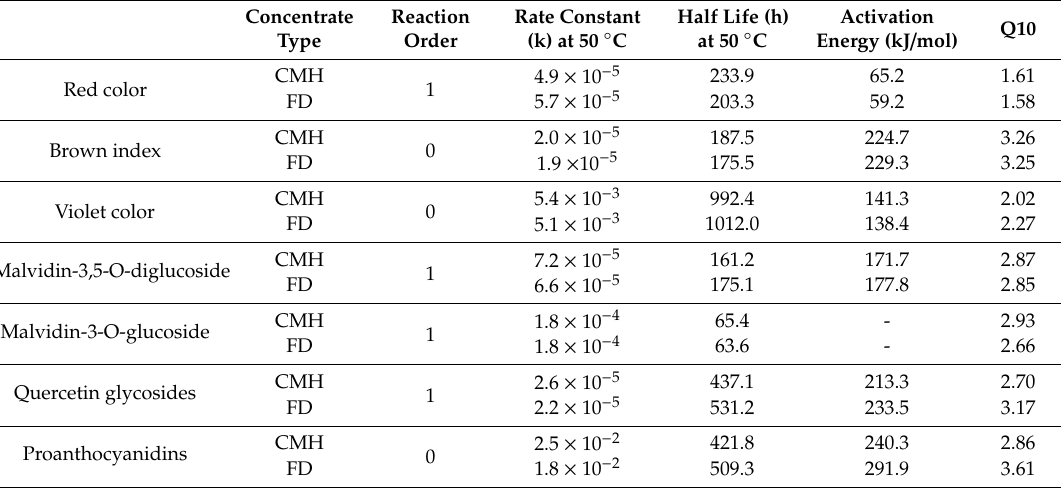
Table 5. Kinetic parameter data for color, phenolic compounds, and 5-hydroxymethylfurfural (5-HMF) for concentrates derived from conventional must heating (CMH) and flash d é tente (FD) concentrates after nine days of accelerated aging at 50 ◦